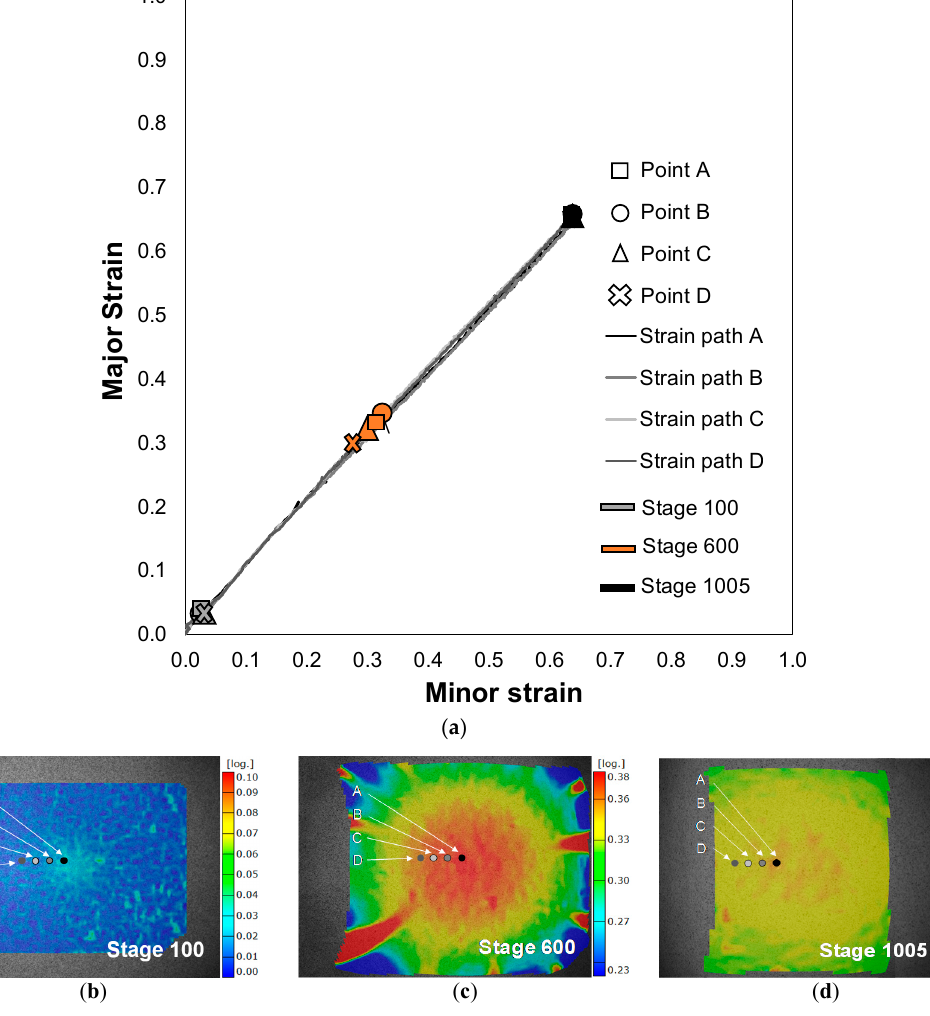
Figure 7. ( a ) Strain path evolution along a section perpendicular to the crack of an EBS specimen for different stages through the Nakajima test. Measured major strains obtained by the DIC system for several stages: ( b ) Initial deformation, stage 100; ( c ) stage 600 and ( d ) stage 1005.